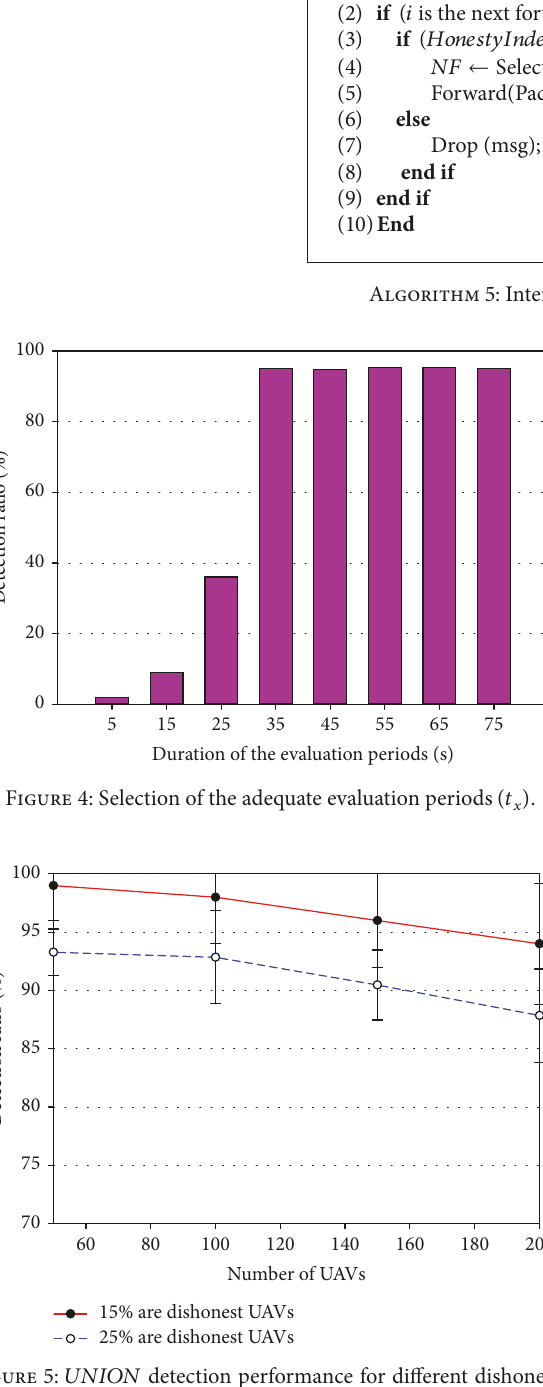
Figure 5: 𝑈𝑁𝐼𝑂𝑁 detection performance for different dishonesty ratios.